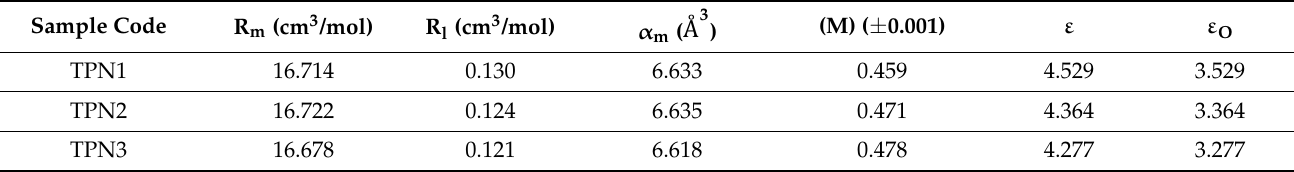
Table 3. The molar refractivity (R m ), reflection loss (R L ), electronic polarizability ( α m ), metallization (M), dielectric constant ( ε ), and optical dielectric constant ( ε O ) values of the studied glasses. Sample Code ( /mol) (